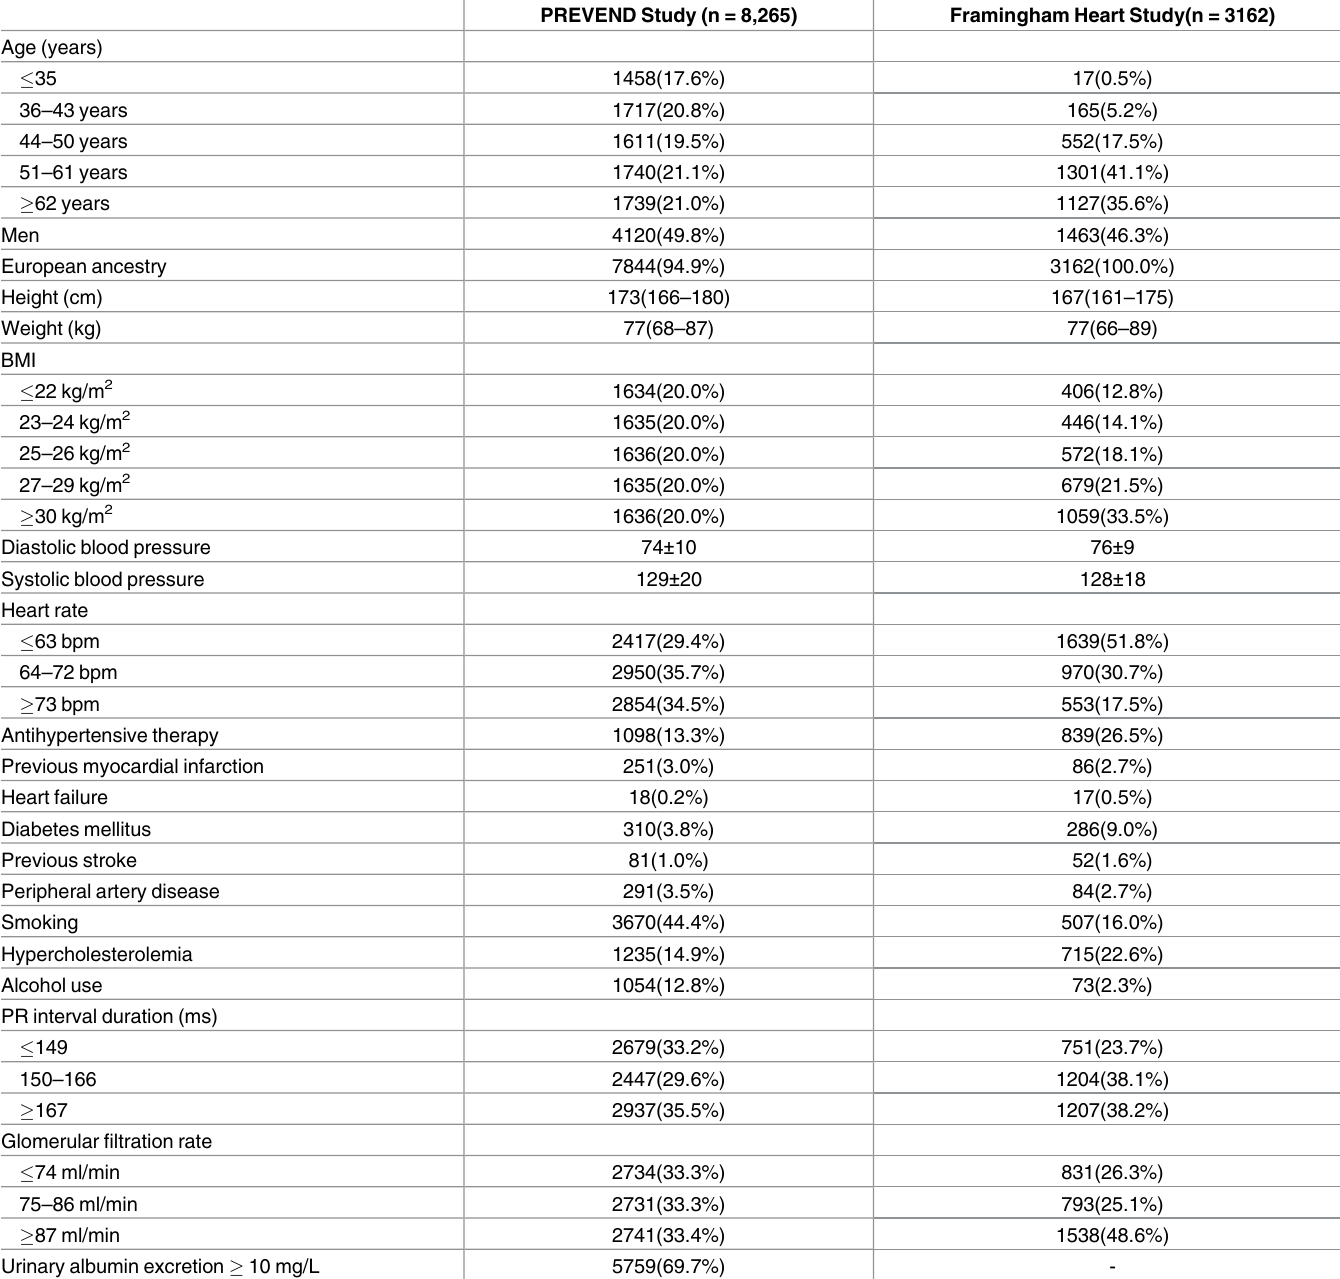
Table 1. Cardiovascular risk factors and diseasesin the PREVEND and Framingham Heart Study